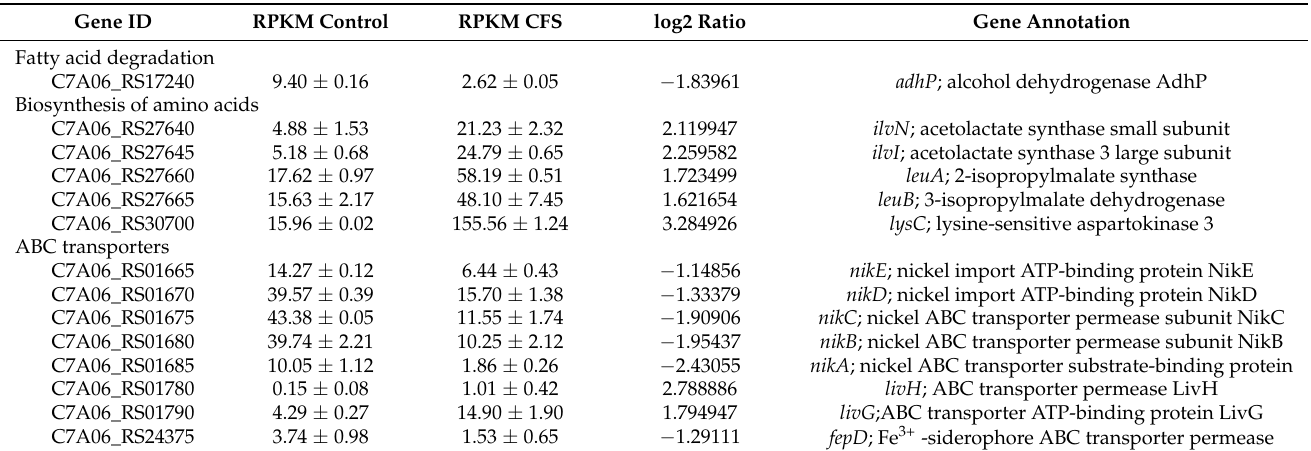
Table 1. Gene annotation and KEGG pathway of the differentially expressed genes in E. coli ATCC25922 in response to CFS from L. rhamnosus SCB0119.